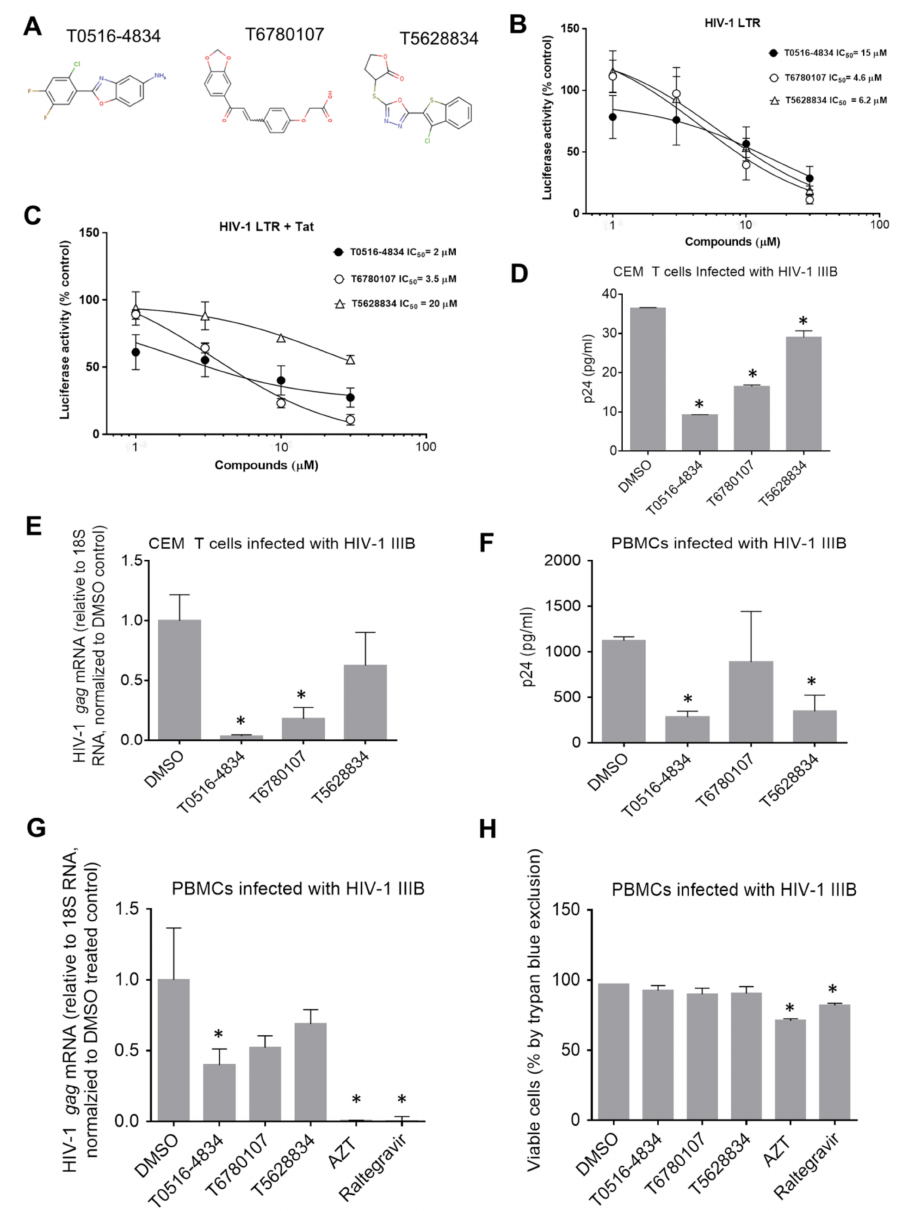
Figure 3. Inhibition of Tat-medicated transcription and HIV-1 replication by TAR RNA-targeting compounds. ( A ) shown are structures for T0516-4834, T6780107 and T5628834 compounds. ( B , C ) inhibition of HIV-1 basal and Tat-activated transcription. 293T cells were transfected with HIV-1 LTR reporter ( B ) or HIV-1 LTR reporter and Tat-expressing vectors ( C ) and treated with indicated concentrations of the compounds for 24 h. Luciferase activity was measured as described in Materials and Methods. Data were plotted in Prims 6. ( D , E ) inhibition of HIV-1 replication in CEM T cells infected with HIV-1 IIIB. The cells were infected for 48 h followed by p24 ELISA ( D ) or RNA isolation and real-time PCR analysis for HIV-1 gag mRNA ( E ). Asterisks indicate p < 0.05 in comparison to the DMSO controls. F and G, inhibition of HIV-1 replication in PBMCs infected with HIV-1 IIIB. PBMCs were activated as described in Materials and Methods and infected with HIV-1 IIIB for 48 h followed by p24 ELISA analysis ( F ) or RNA isolation and real-time PCR analysis for HIV-1 gag mRNA ( G ). ( H ) PBMCs viability tested with trypan blue exclusion assay for samples from ( G ). Asterisks indicate p < 0.05 in comparison to the DMSO